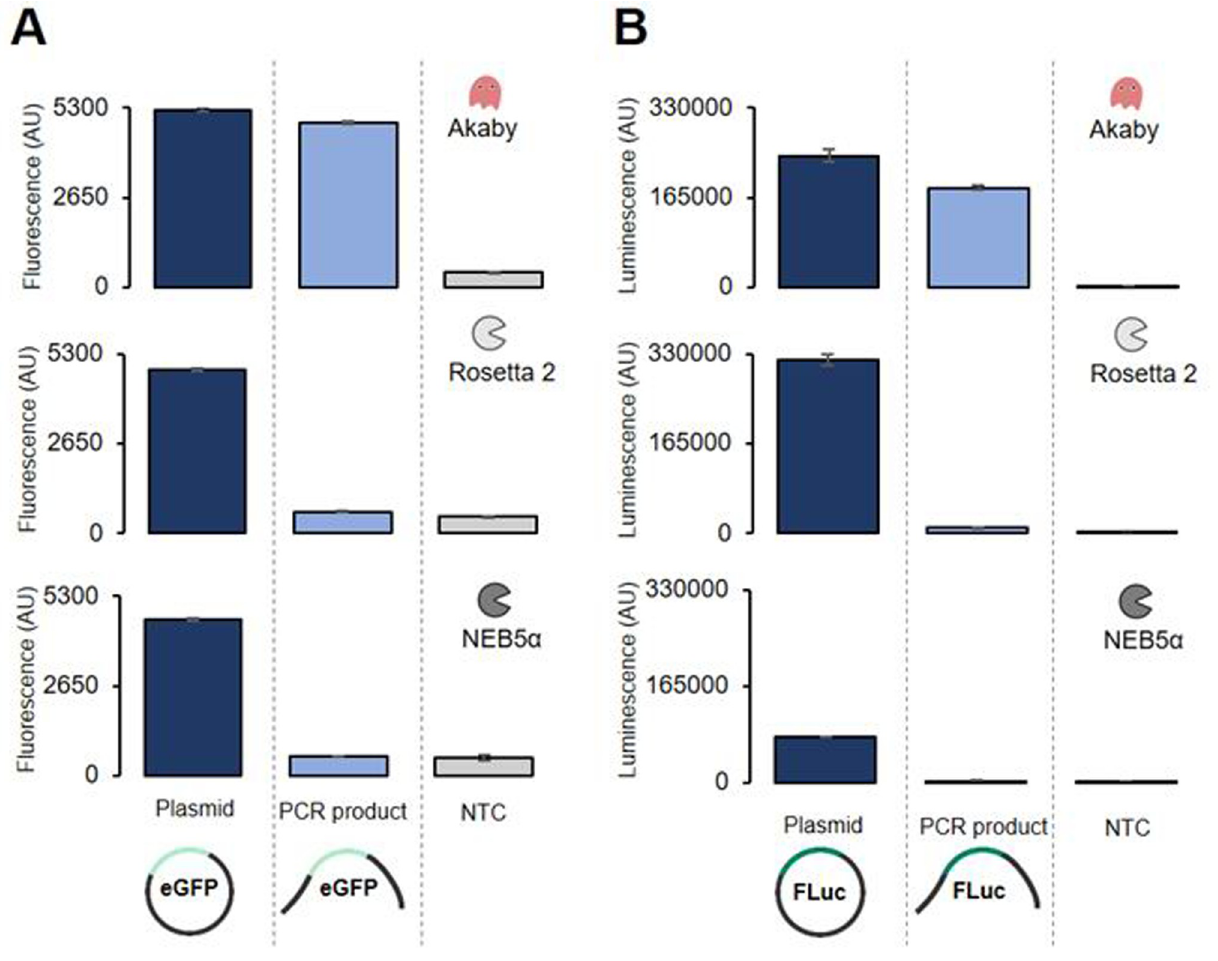
Fig 5. Protein expression from PCR amplified genes in Akaby, Rosetta 2, and NEB5 α TXTL. eGFP and firefly luciferase (FLuc) was expressed in Akaby, Rosetta 2, or NEB5 α TXTL at 30˚C for 8 hours. The linear PCR product was prepared by PCR amplification from the plasmids. Both the plasmid and the PCR product template concentrations were 5 nM. (A) eGFP fluorescence measured at λ ex 488 nm and λ em 509 nm. (B) The luminescence measurement in FLuc expressing TXTL reactions. After TXTL reaction, 10 μ M D-luciferin, 1 mM ATP, and 5 mM MgCl2 were added to the TXTL. The luminescence was measured immediately without emission filters. The graphs show means with error bars that signify SEM (n = 3).